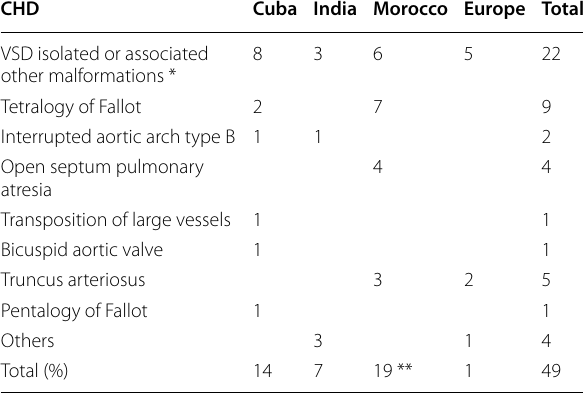
Table 4 Heart defects observed in patients with 22q11 deletion; abbreviations: CHD—congenital heart disease, VSD—ventricular septum